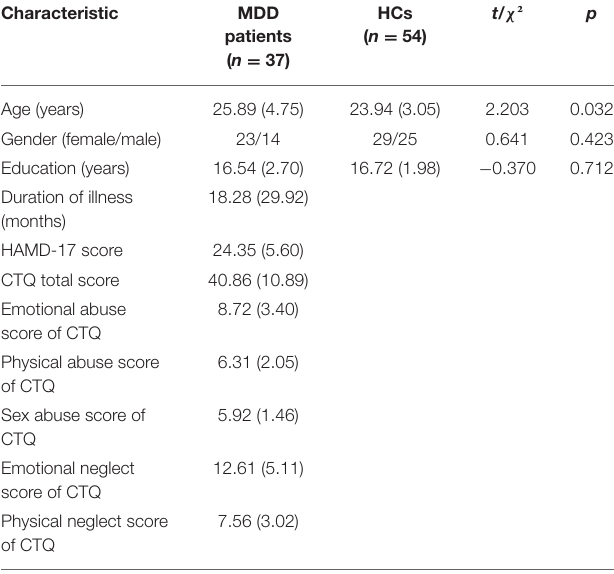
TABLE 1 | Demographic and Behavioral Characteristics of MDD patients and HCs.